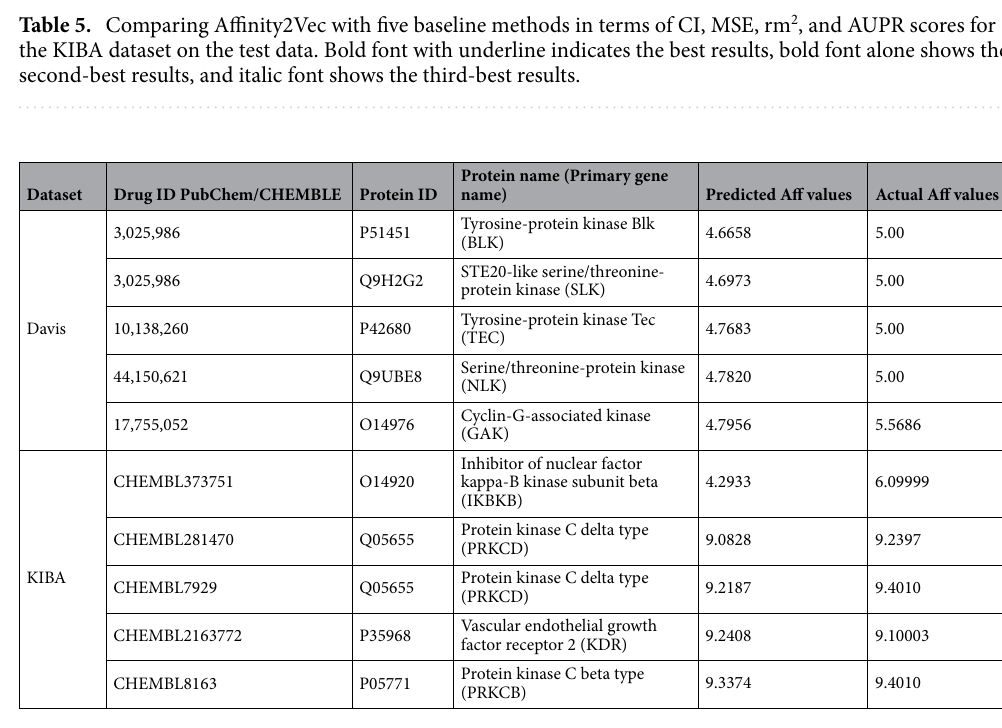
Table 6. Predicted and actual affinity values of the top 5 drug-target pairs for Davis and KIBA datasets. The lower the affinity (AFF) value, the stronger the binding between drug and protein. The strongest binding affinity value in the Davis dataset is 5.00, while is 6.1 the strongest binding affinity value in the KIBA dataset after removing the zero values.